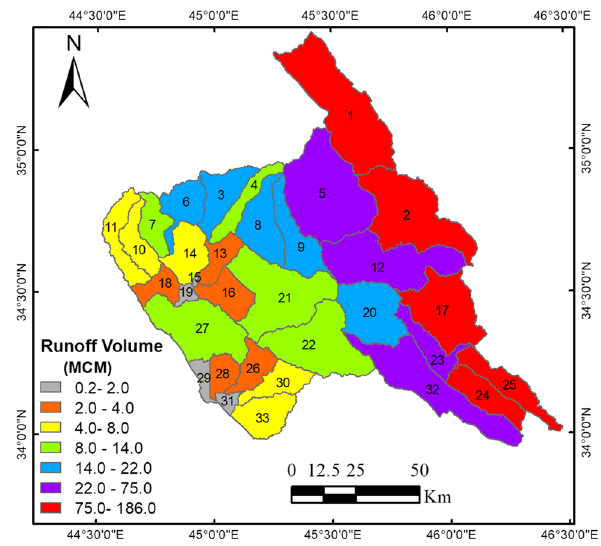
Fig. 19 Average spatially runoff volume in MCM contributed by sub- basins for the period